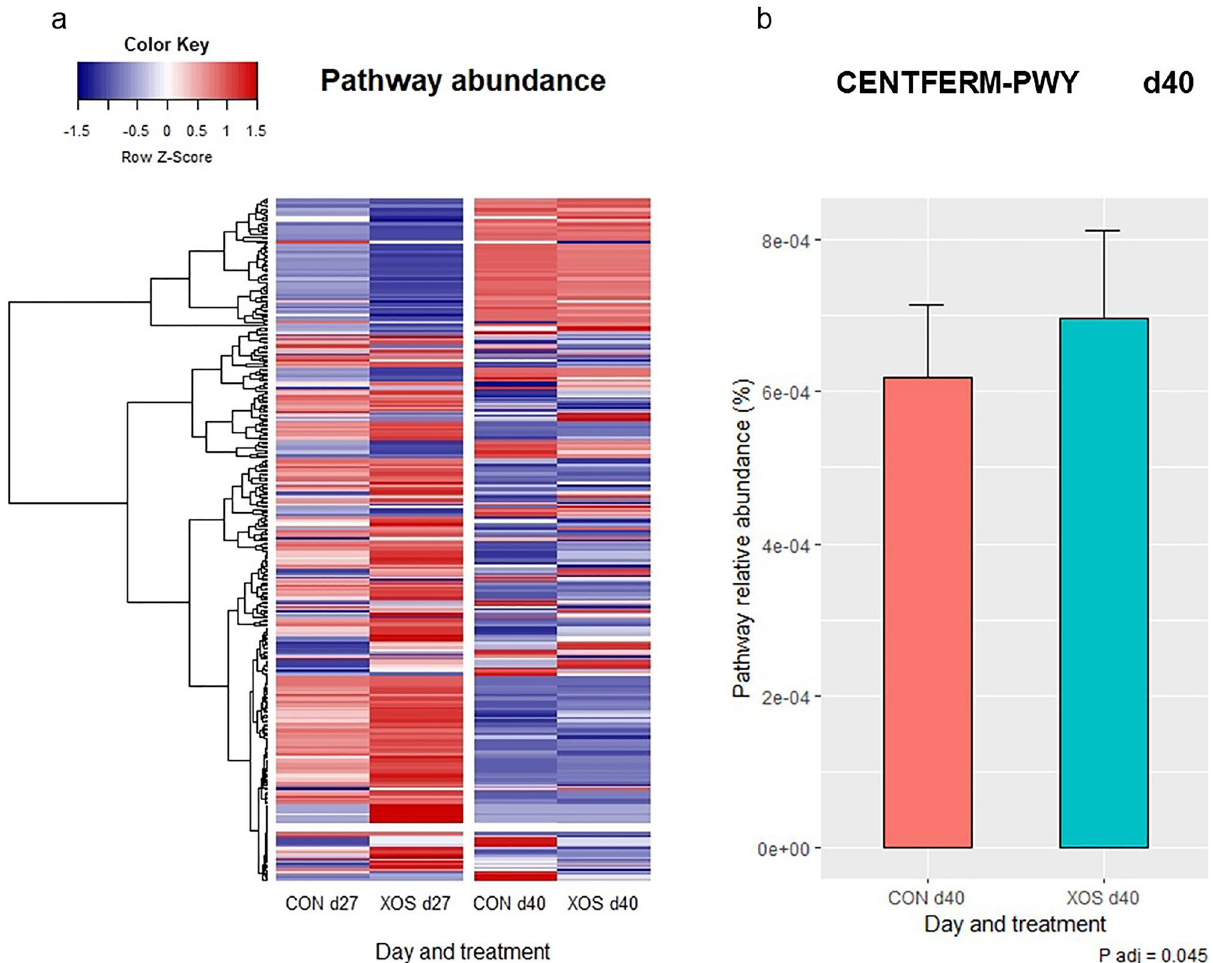
supplemented with xylooligosacharides (XOS) at the end of lactation period (d27) and during the nursery period (d40). ( a ) Heatmap representing the mean relative abundance of each predicted pathways in each treatment. The color represent the Z-scores (row-scaled relative abundance) from low (blue) to high values (red). Predicted pathways (rows) were clustered by the average method. ( b ) Bar plot representing the relative abundance of the CENTFERM-PWY predicted pathway at d40. Error bar represents standard error of the mean. d27 CON: fecal samples of piglets supplemented with water on day 27; d27 XOS: fecal samples of piglets supplemented with XOS on day 27; d40 CON: fecal samples of piglets supplemented with water on d40; and d40 XOS: fecal samples of piglets supplemented with XOS on d40. Figure created by using open-source software